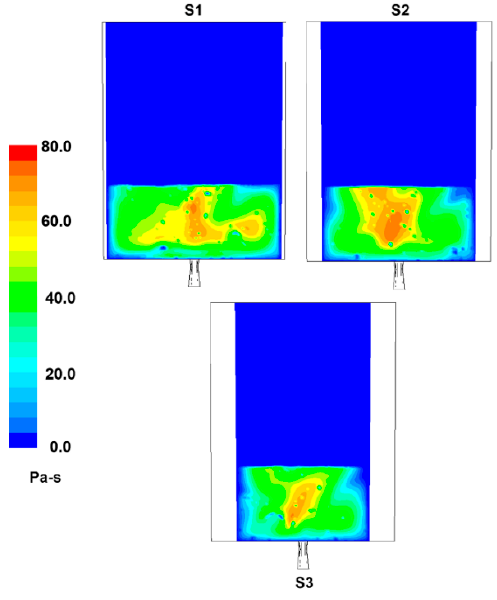
Figure 10. Fields of Turbulent viscosity (Pa-s) in planes of the South sector at a bath level of 30 tons.